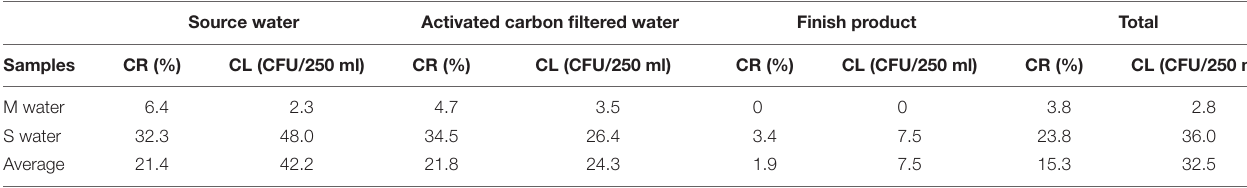
TABLE 2 | Prevalence of E. faecalis from mineral water and spring water in